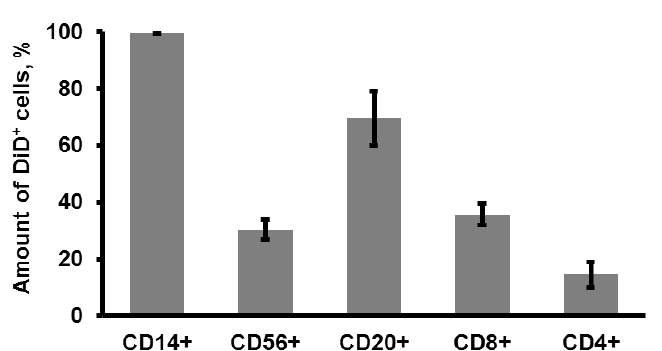
Figure 3. Cytochalasin B-induced membrane vesicles – mesenchymal stem cells (CIMVs-MSCs) uptake by leukocytes. CIMVs-MSCs (10 µ g) stained with membrane dye DiD were incubated with peripheral blood mononuclear cells (PBMCs) for 24 h. PBMCs were incubated with antibodies to CD markers (anti-CD45, anti-CD3, anti-CD4, anti-CD8, anti-CD20, anti-CD14, and anti-CD56 monoclonal antibodies) and analyzed using flow cytometer BD FACS Aria III (BD Bioscience, USA). Experiments were repeated three times. The data represent mean ± SD.